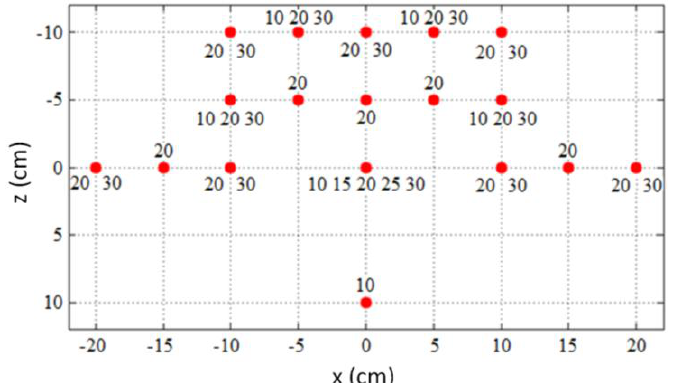
Figure 5. The measurement grid displaying the reference locations of the static